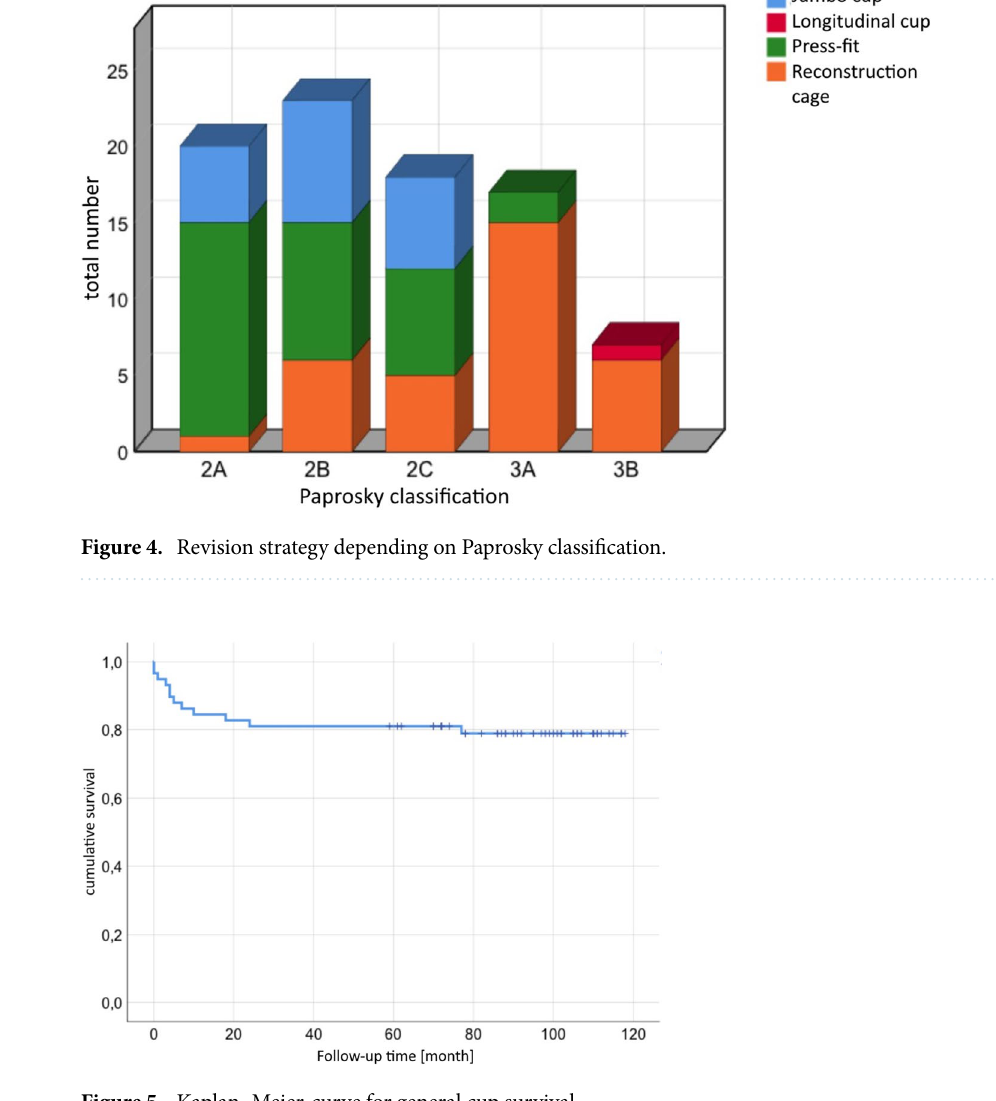
Figure 5. Kaplan–Meier-curve for general cup survival.